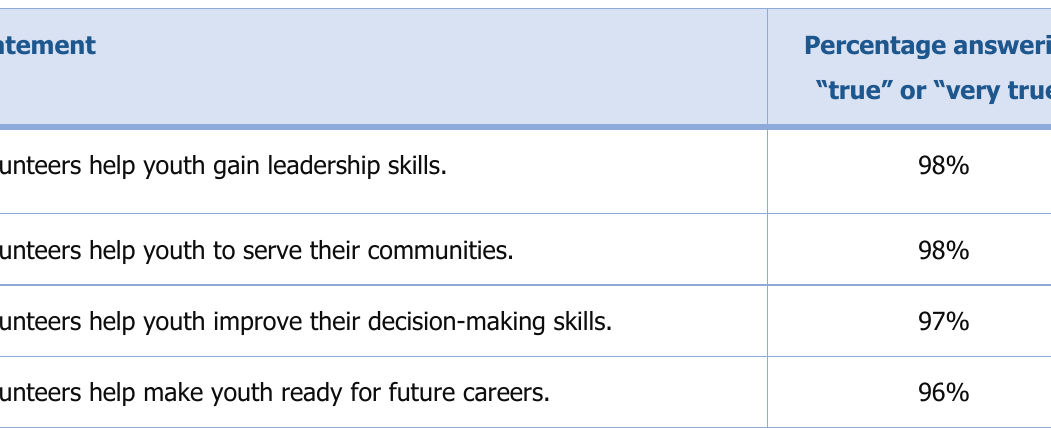
Table 5. Volunteers Support Youth